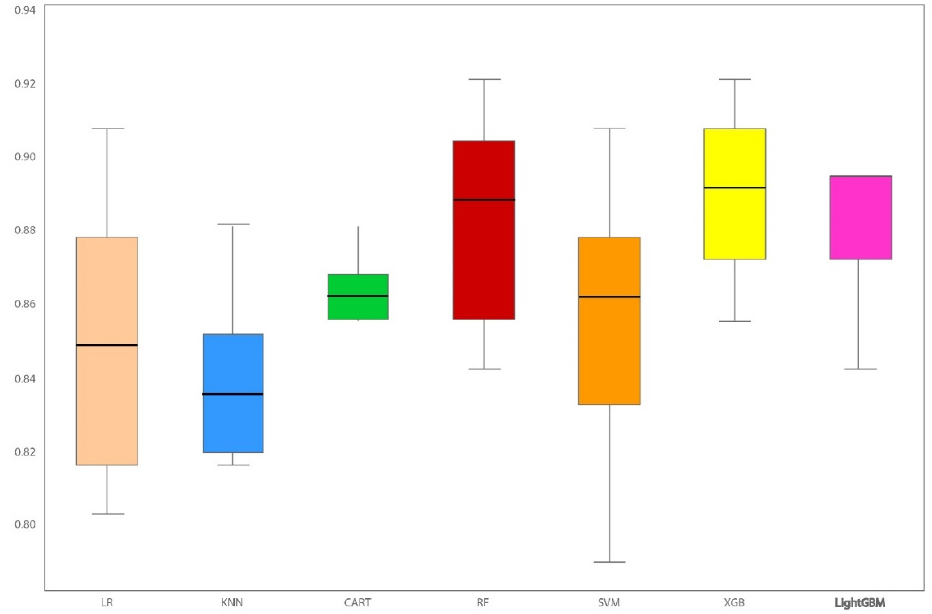
Figure 8. Statistical analysis of seven classifiers with accuracy.